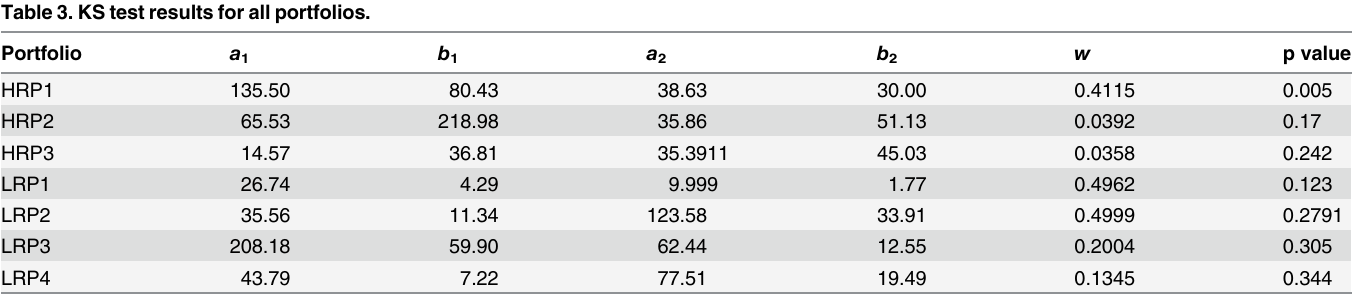
Table 3. KS test results for all